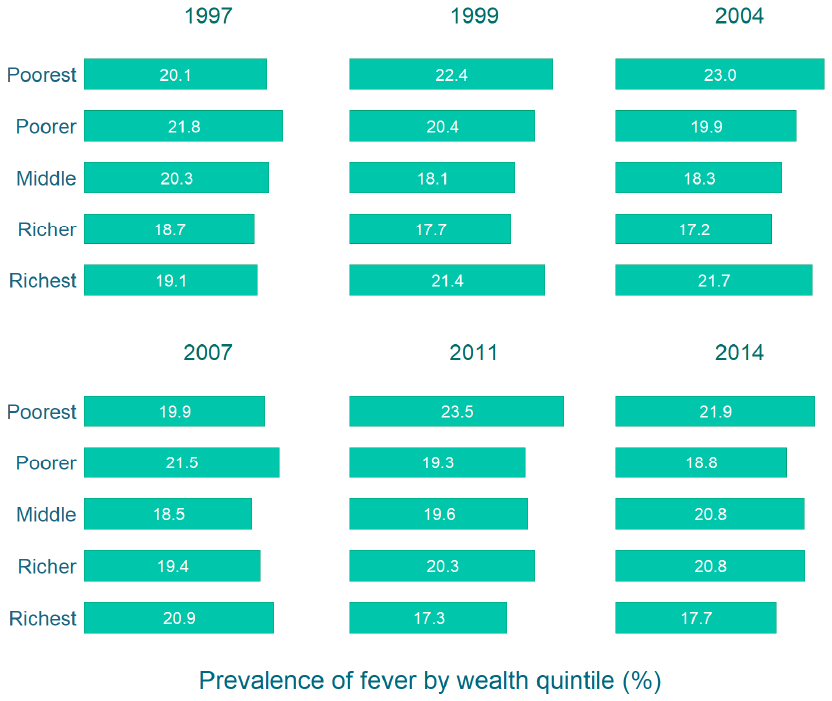
Figure 3. Prevalence of fever among under-five children by household wealth quintile in Bangladesh 1997–2014.